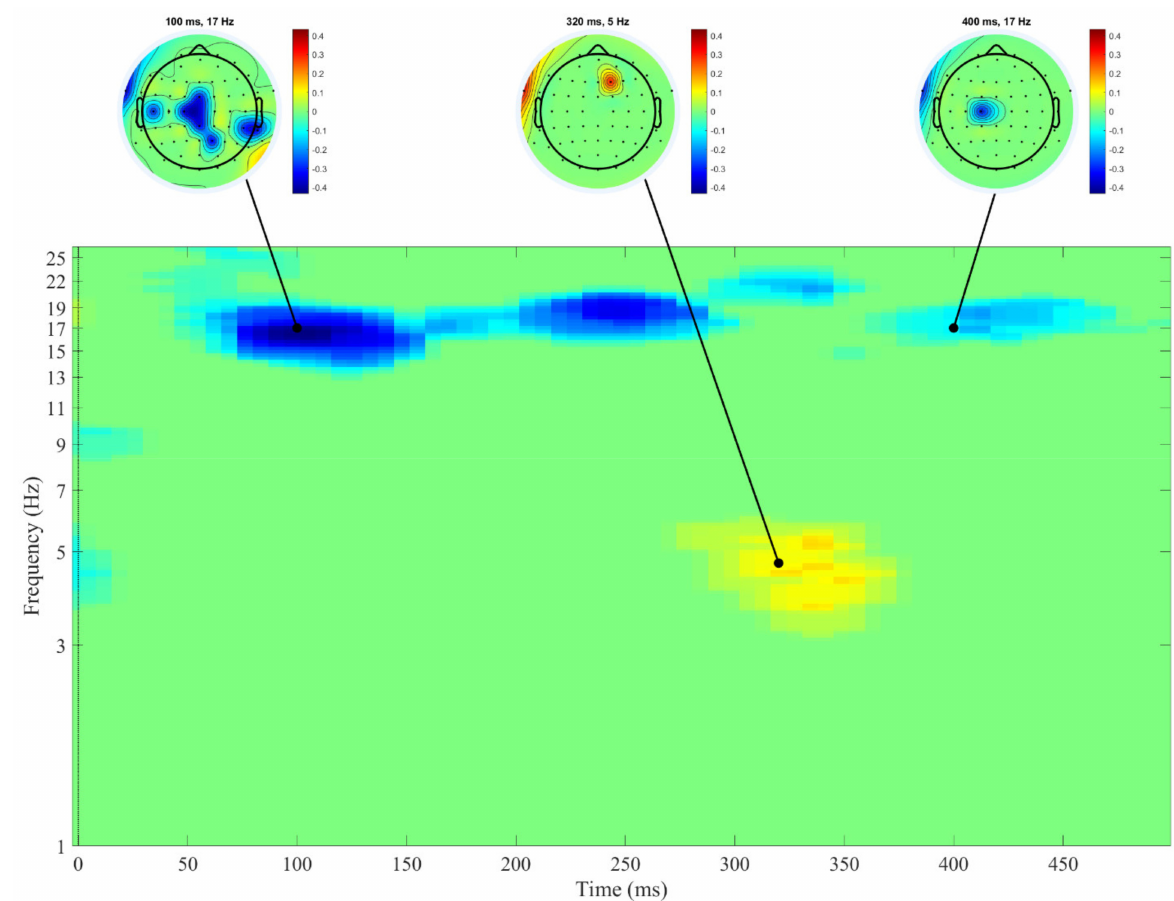
Figure 2. Correlations between hyperactivity/inattention scores and ERSPs after the presentation of Go stimulus. Positive correlation coefficients are shown in warm colors, negative correlation coefficients are shown in cool colors. Darker colors correspond to stronger correlations (see vertical bars for exact values). Time-frequency areas with non-significant correlation coefficients are shown in green. The moment when the stimulus was presented is represented by 0. Heads at the top of the figure display the distribution of significant correlation coefficients across the electrodes. n =